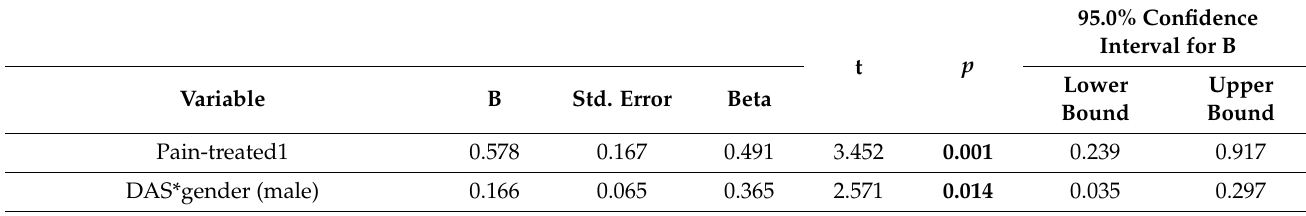
Table 3. Stepwise regression analyses to determine possible predictors of the highest level of PDP experienced by patients